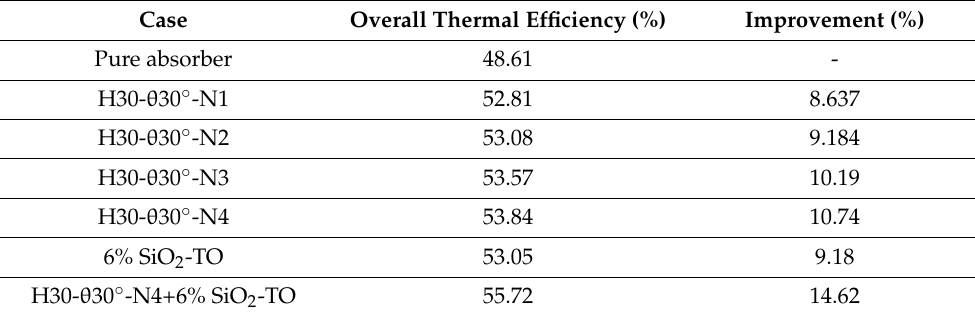
Table 9. Overall thermal efficiency enhancement for single and multiple conical insert cases with and without nanofluid at Re =